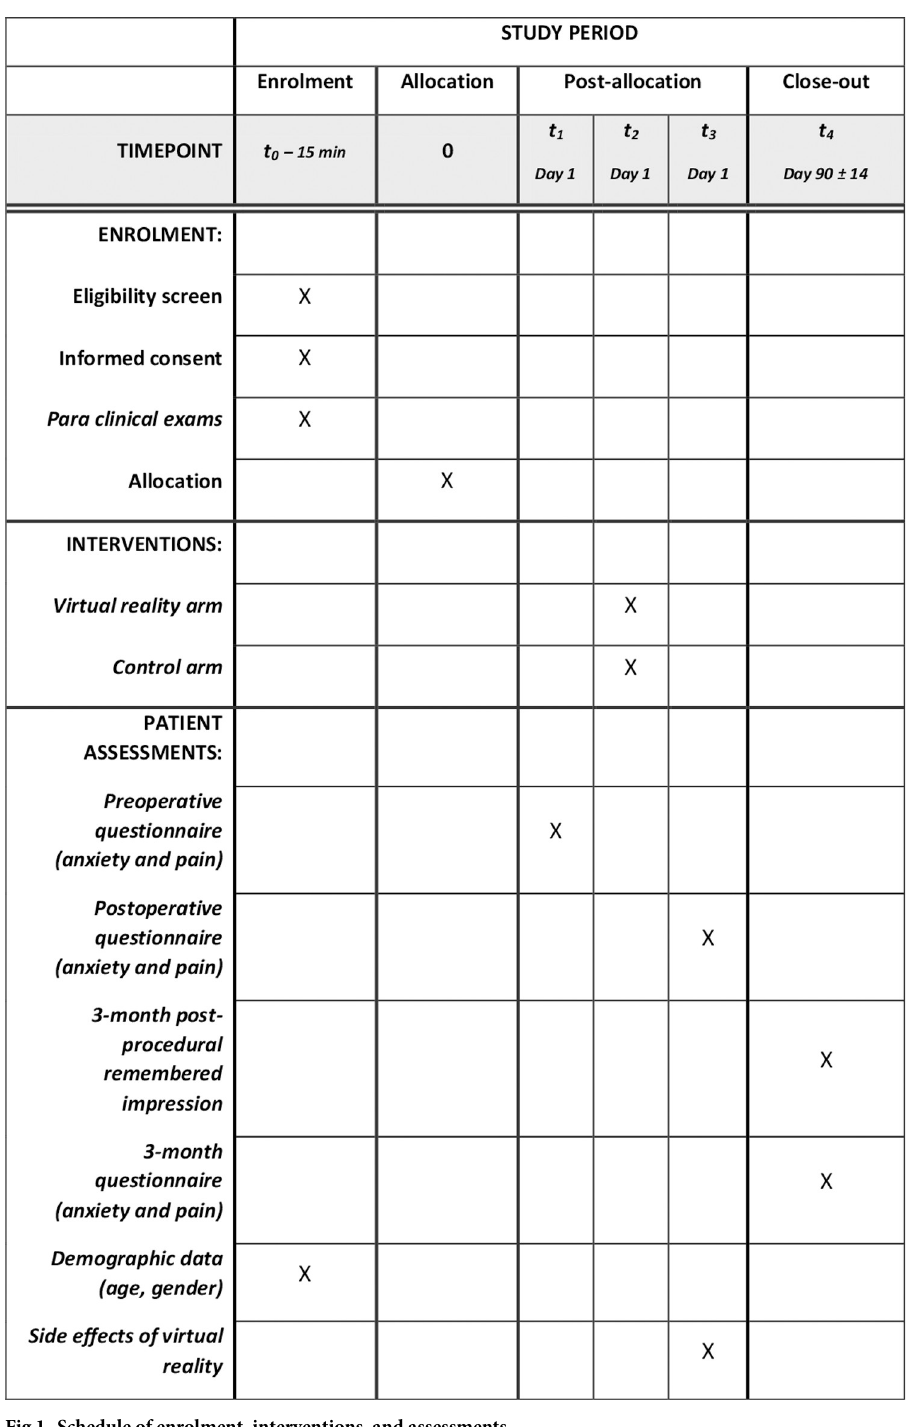
Fig 1. Schedule of enrolment, interventions, and assessments.